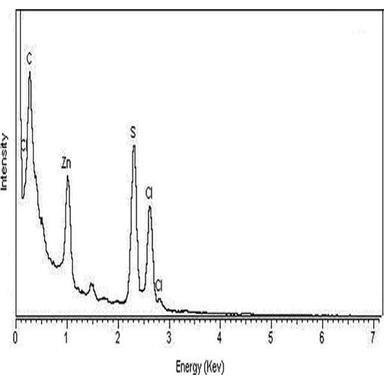
EDX spectrum of ATZC crystal.